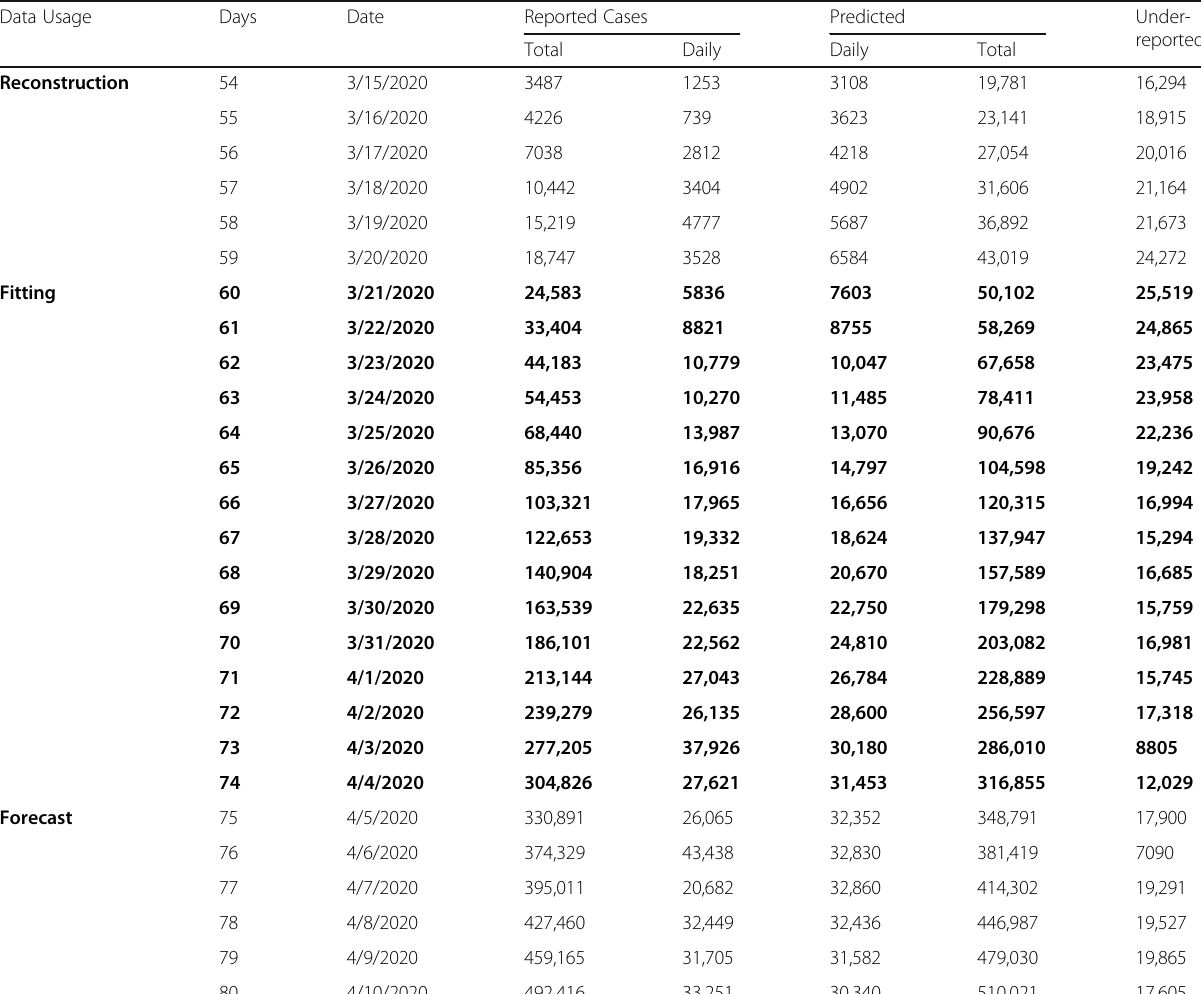
Table 2 Illustration of data usage with reported, predicted, and underreported